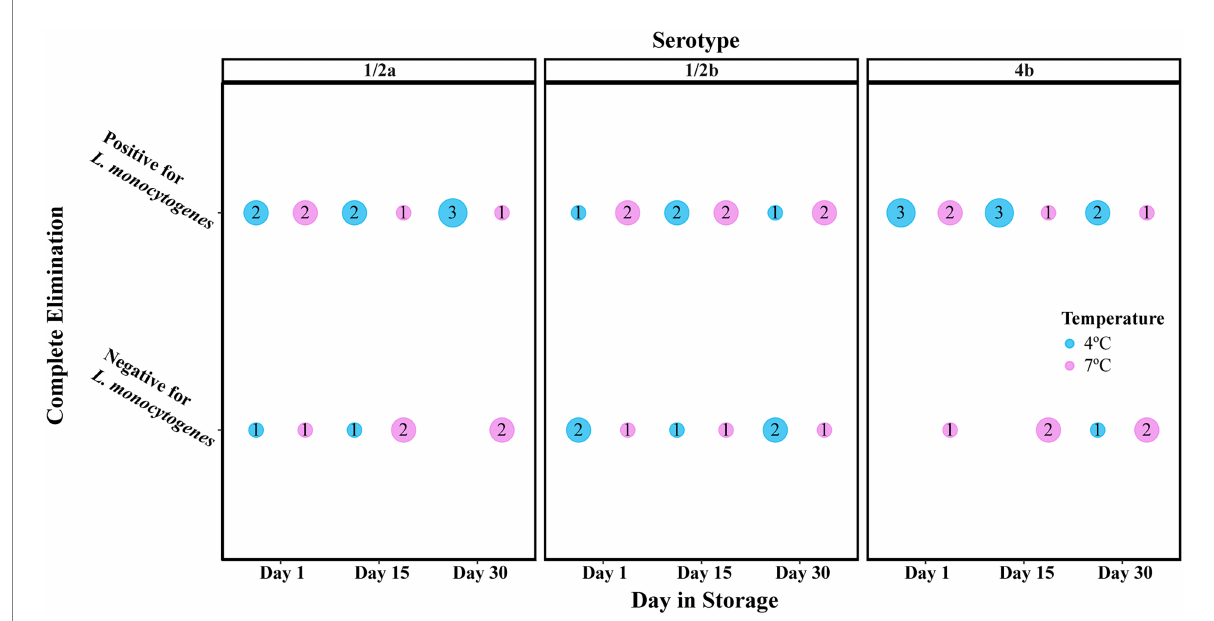
FIGURE 1 Presence/absence of Listeria monocytogenes on 10-g cold-smoked salmon samples treated with 250 ppm nisin. For each combination of storage temperature, serotype, and day in storage, the number of samples positive and negative for L. monocytogenes are indicated in the center of the circles. The size of the circles is in proportion to the number of